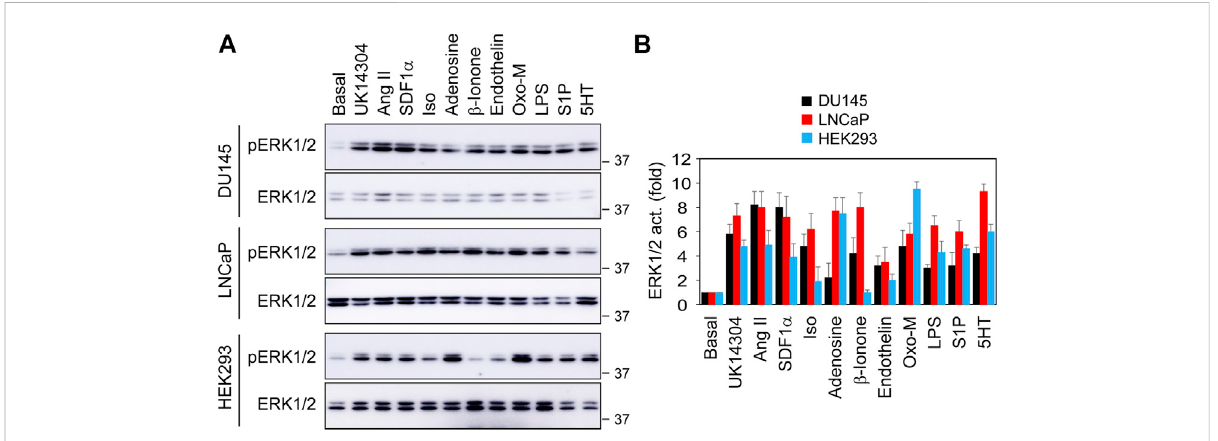
FIGURE 2 Comparison of ERK1/2 activation by different GPCR agonists in DU145, LNCaP and HEK293 cells. (A) ERK1/2 activation in response to stimulation with different GPCR agonists and LPS. The cells were cultured on 6-well dishes, starved for 24 h (HEK293 cells) or 48 h (DU145 and LNCaP cells) and then stimulated for 5 min with UK14340 (1 μ M), Ang II (1 μ M), SDF1 α (25 nM), Iso (10 μ M), β -ionone (100 μ M), adenosine (10 μ M), endothelin (100 nM), Oxo-M (10 μ M), S1P (125 nM), 5HT (15 nM), and LPS (1 μ g/ml). (B) Quantitative data shown in A. The quantitative data are presented as means ± SE ( n =